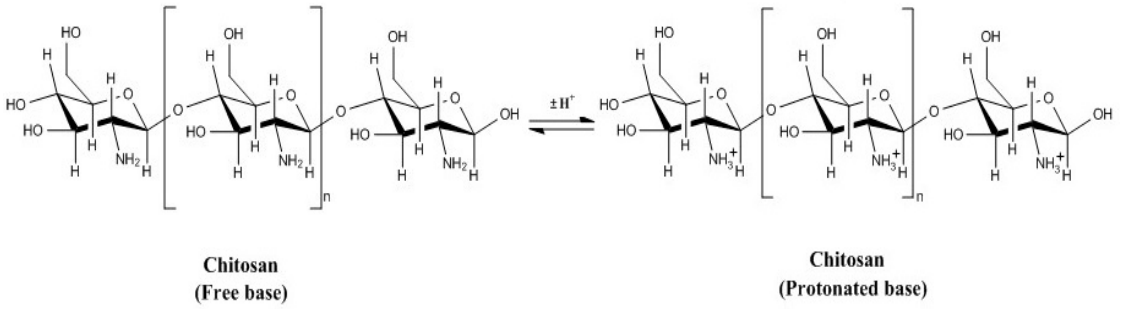
Figure 1. The acid-base equilibrium attributes of CS.